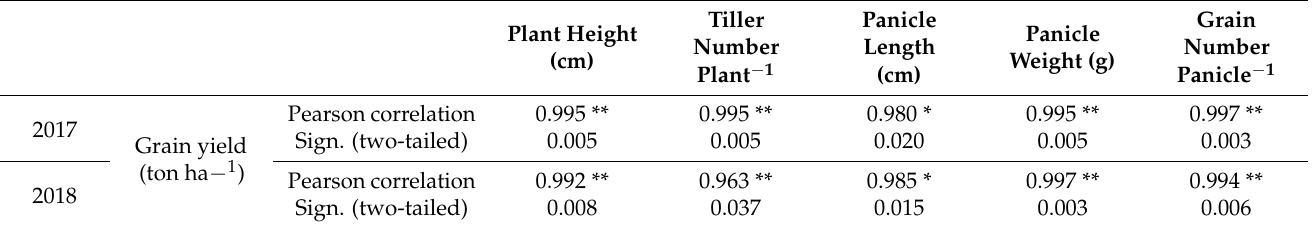
Table 10. Pearson correlation between grain yield (ton ha − 1 ) among the four irrigation treatments and other yield parameters for 2017 and